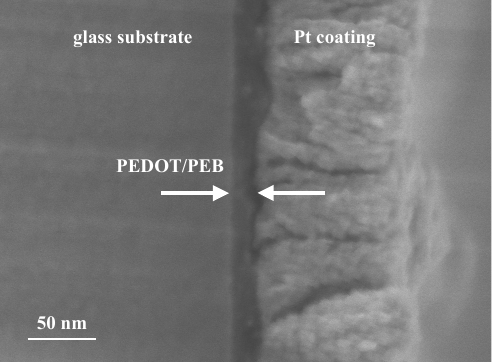
Figure 2. SEM micrograph of a cross-section of the PEDOT/PEB film. A porous layer on the right side is Pt coating for SEM observation.